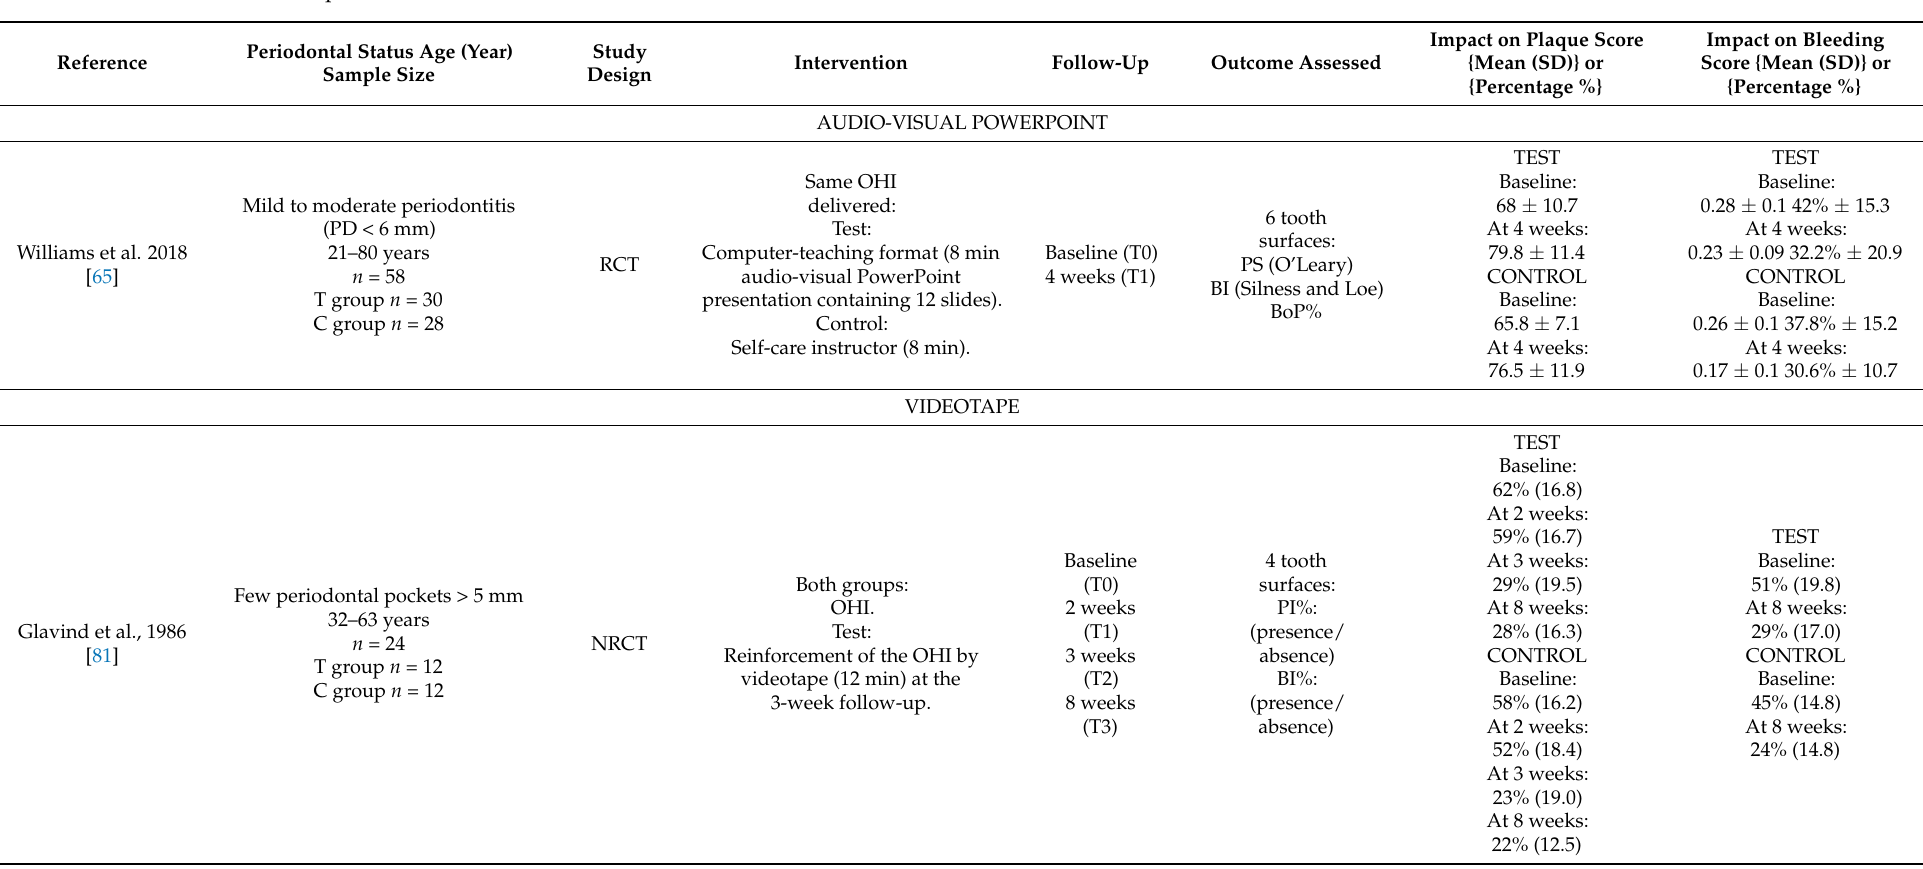
Table 1. Description of the included studies exploring the impact of the OH instructional mode on the behavior and periodontal status of patients with periodontal